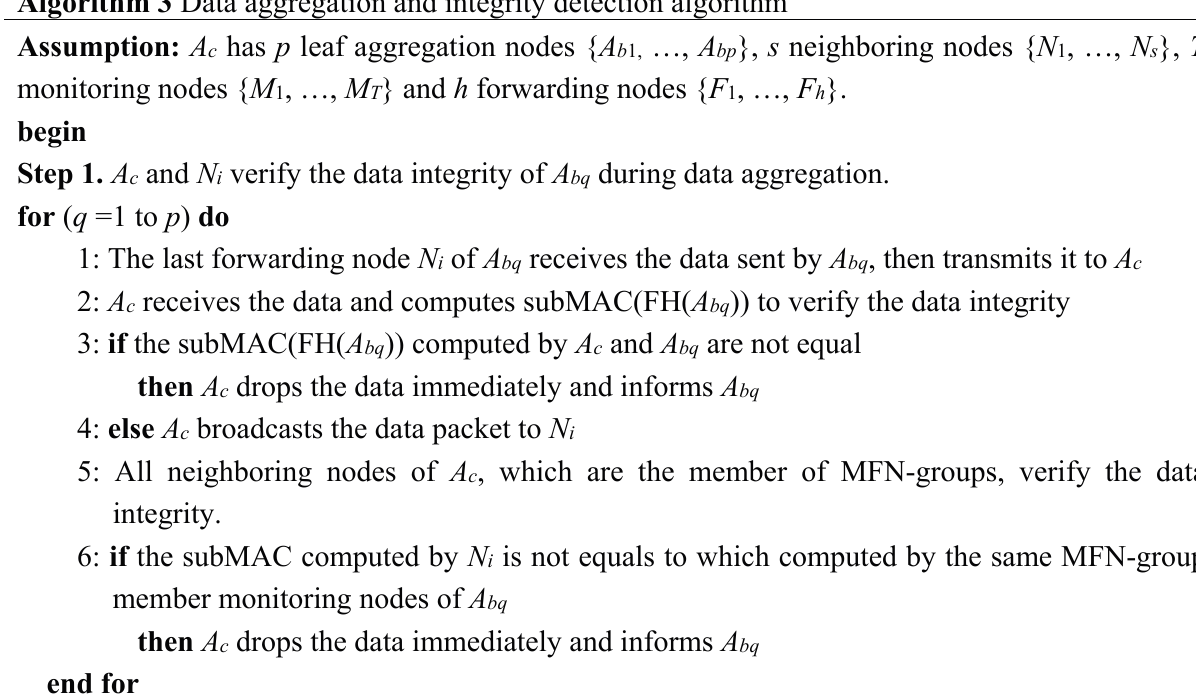
Algorithm 3 Data aggregation and integrity detection